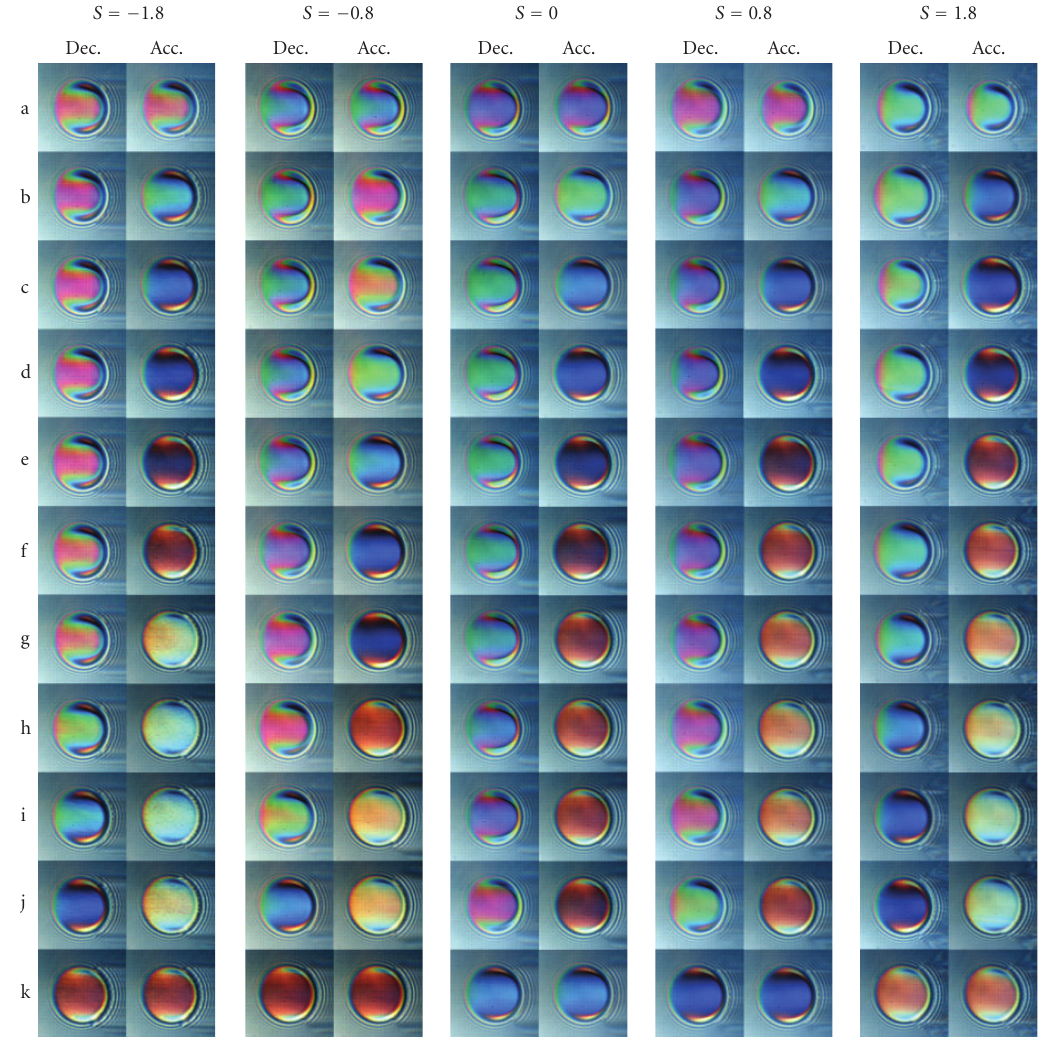
Figure 15: Interferograms obtained under transient conditions. Test frequency: 1Hz. (Entraining velocities u e : a = 0.2250, b = 0.2065, c = 0.1880, d = 0.1695, e = 0.1510, f = 0.1325, g = 0.1140, h = 0.0955, i = 0.0770, j = 0.0585, k = 0.0400 m/s).